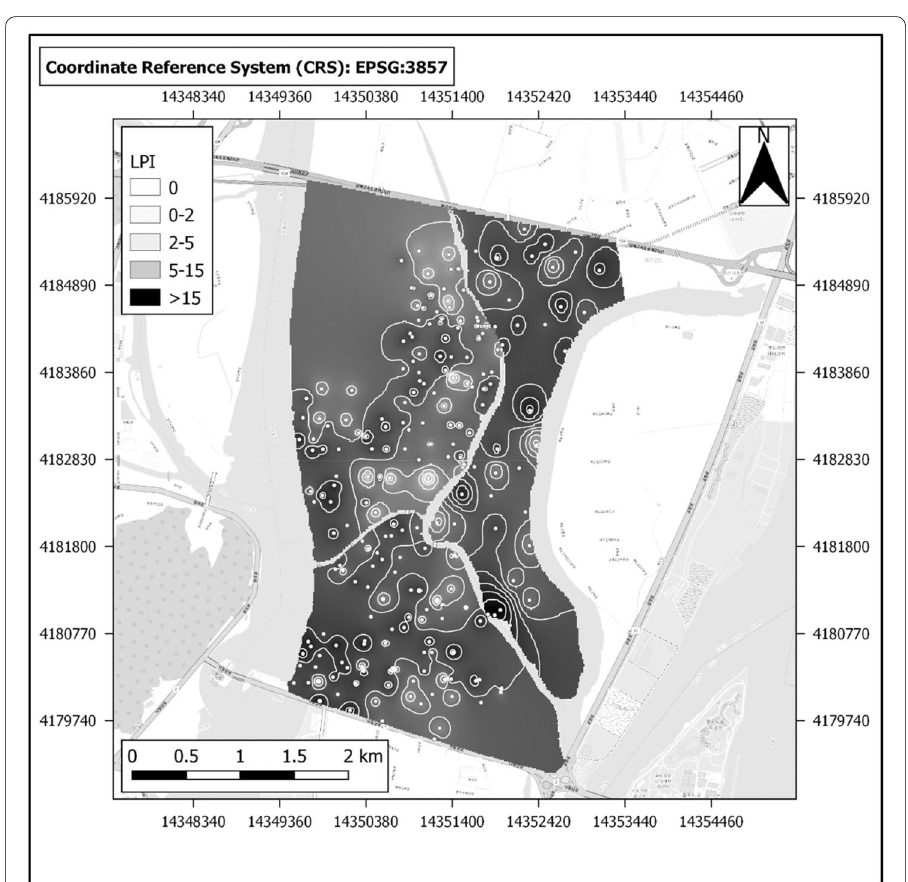
Fig. 13 Liquefaction hazard map based on Seed and Idriss [1] method for case